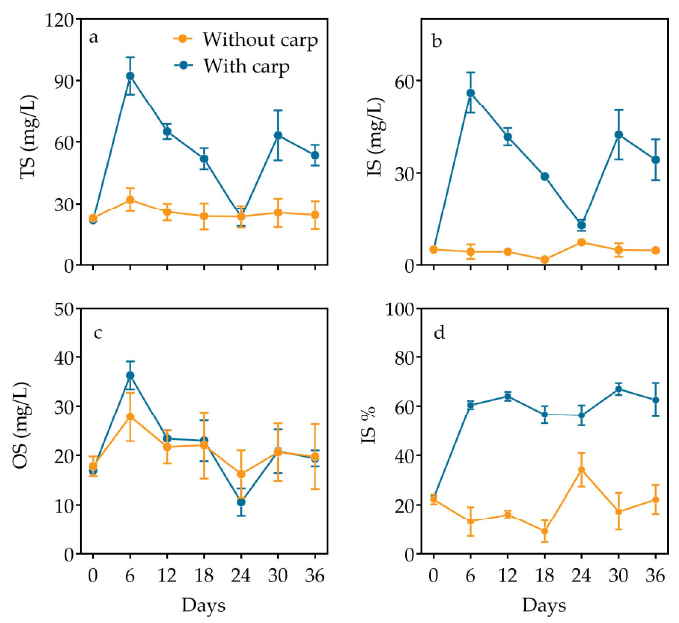
Figure 6. Comparisons of ( a ) total (TS), ( b ) inorganic (IS), ( c ) organic (OS) solid mass, and ( d ) percentage of IS in TS (IS%) between the fish-present and -absent treatments. Values denote mean ± SE ( n = 3).